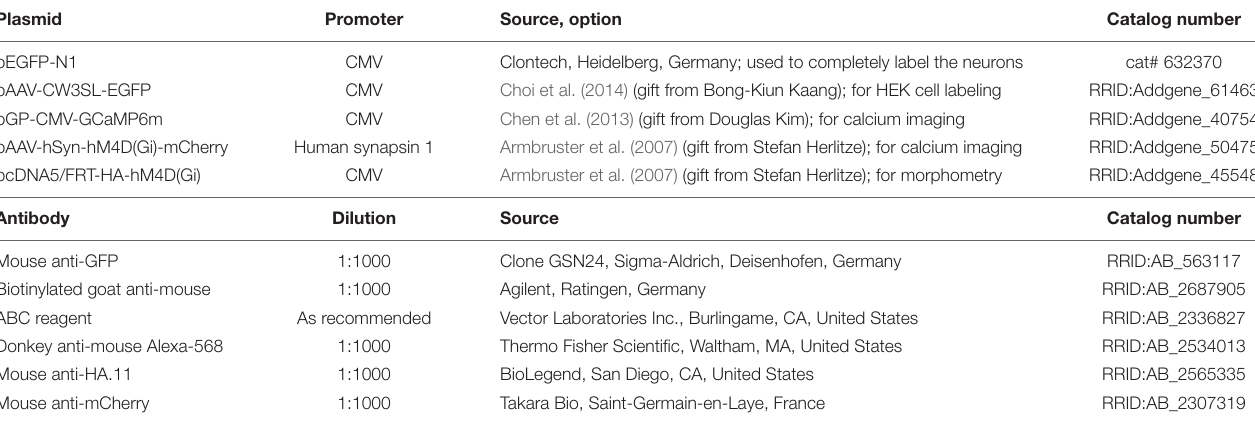
TABLE 1 | Plasmids and reagents.